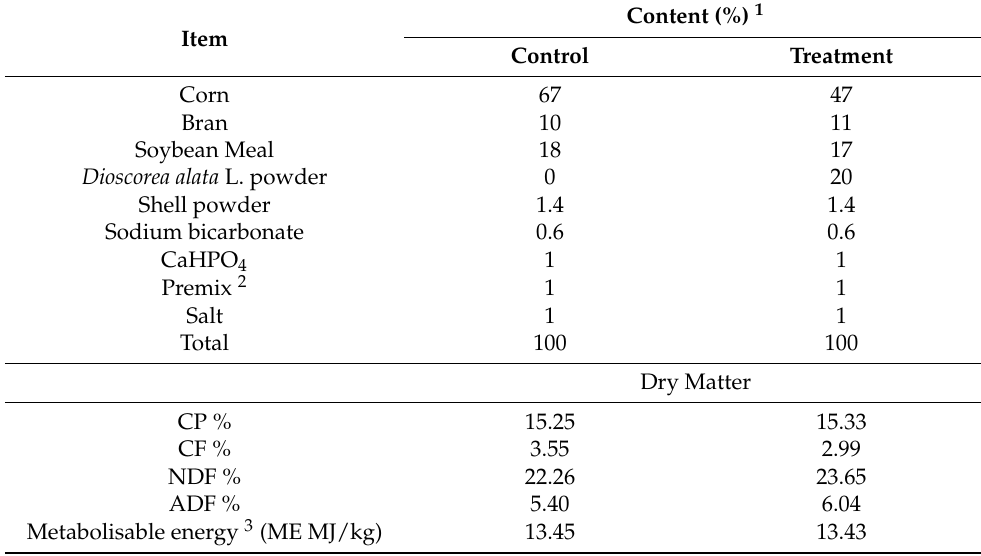
Table 2. Concentrate